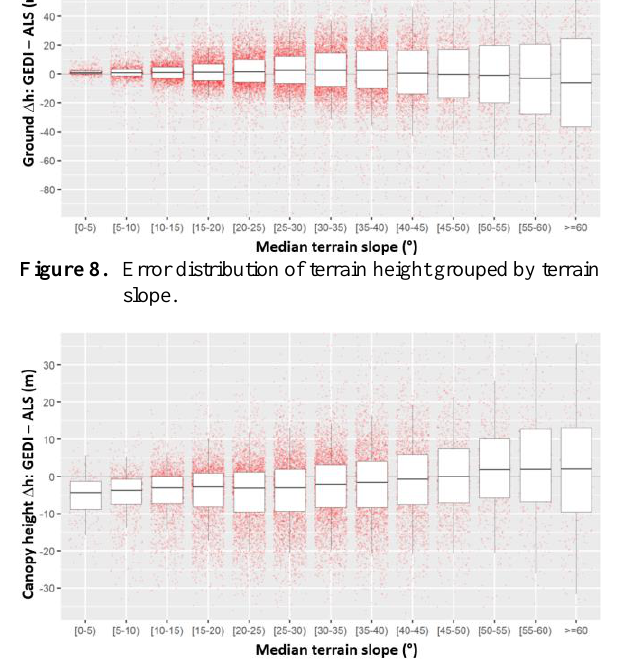
Figure 9. Error distribution of canopy height grouped by terrain slope.